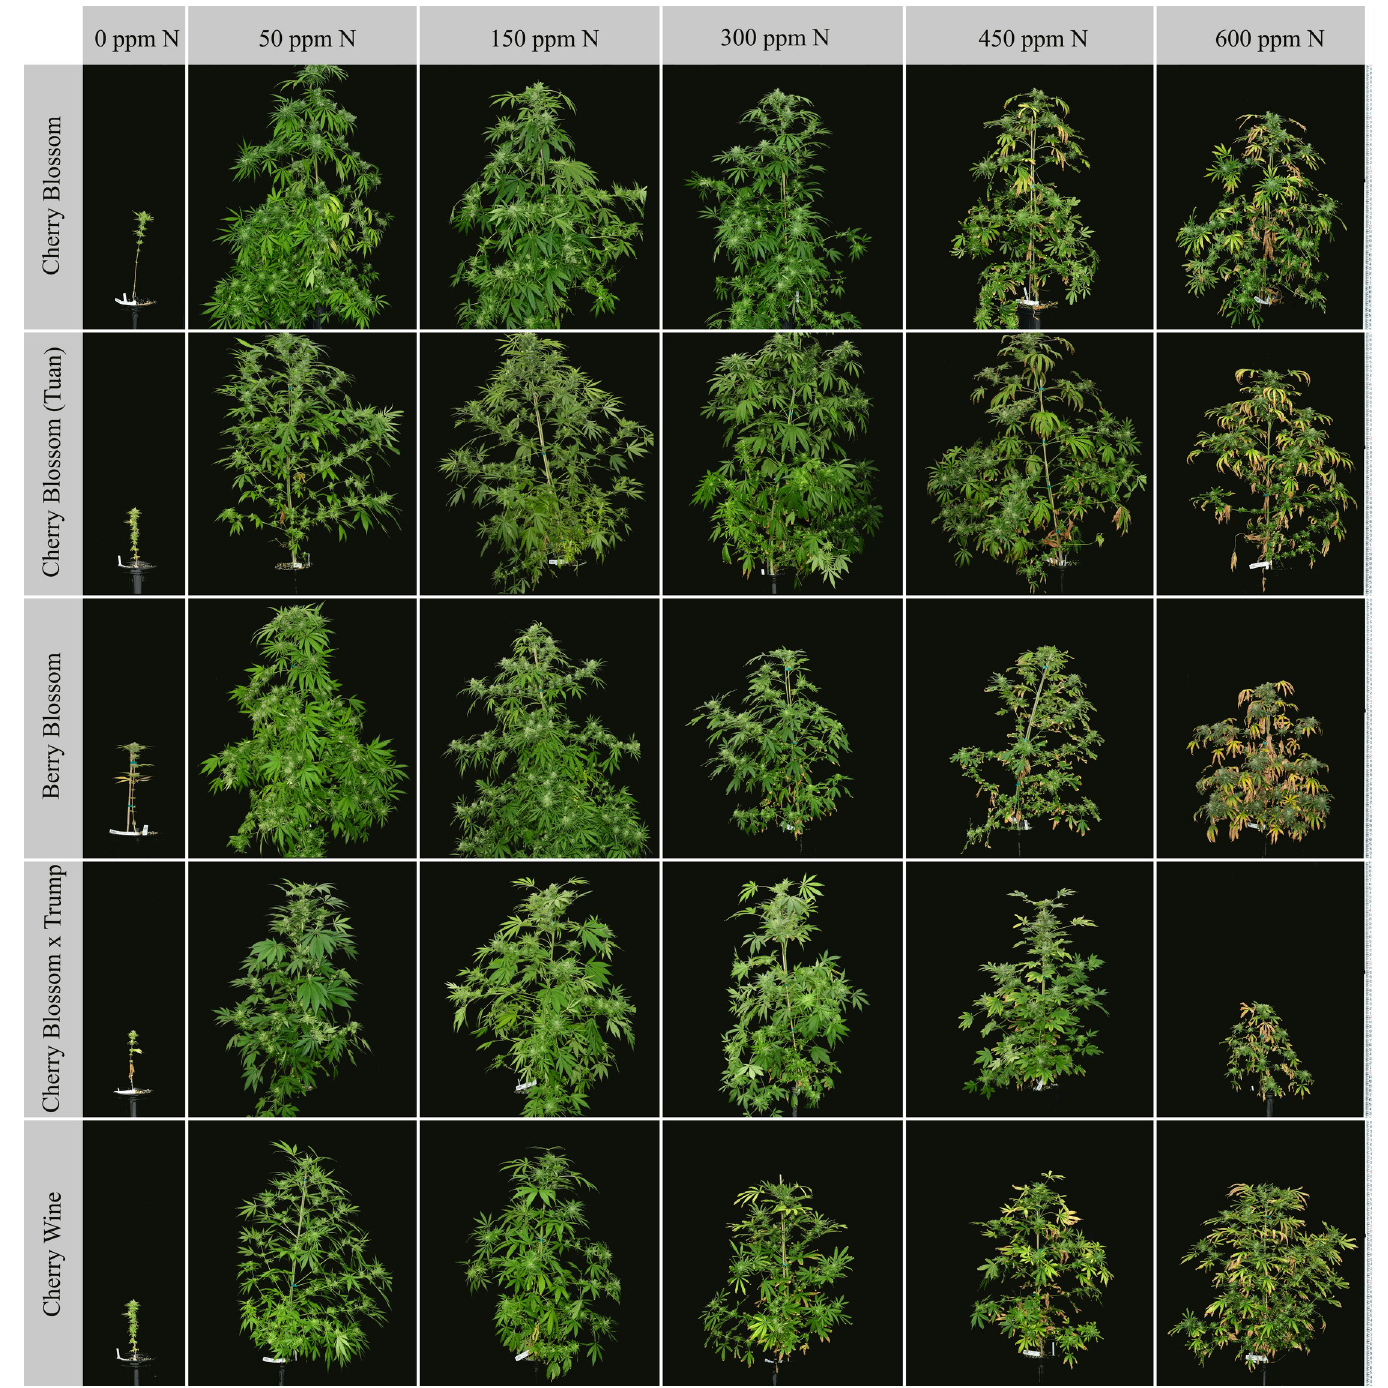
Fig 1. Visual appearance of plants one week prior to harvest. Columns represent fertilizer rates of 0, 50, 150, 300, 450, and 600 ppm N from left to right. Rows represent cultivars Cherry Blossom, Cherry Blossom (Tuan), Berry Blossom, Cherry Blossom × Trump, and Cherry Wine in descending order.